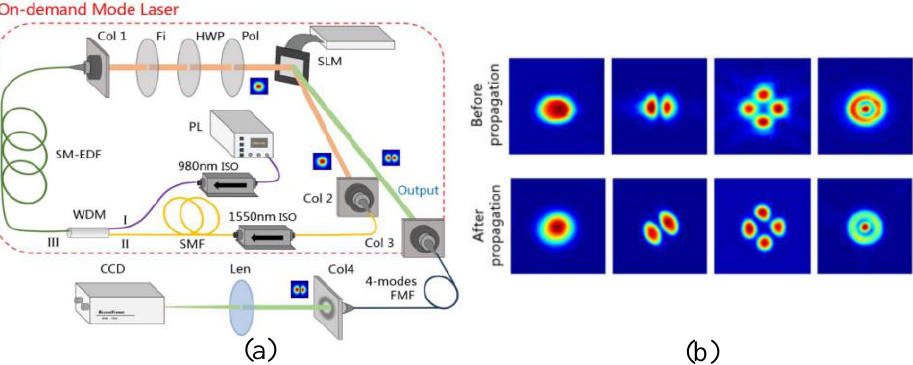
Figure 13. ( a ) Schematic of structured light laser with switchable modes and ( b ) intensity profiles of the different modes in few-mode fibre (Adapted from an open-access source Ref. [97]).